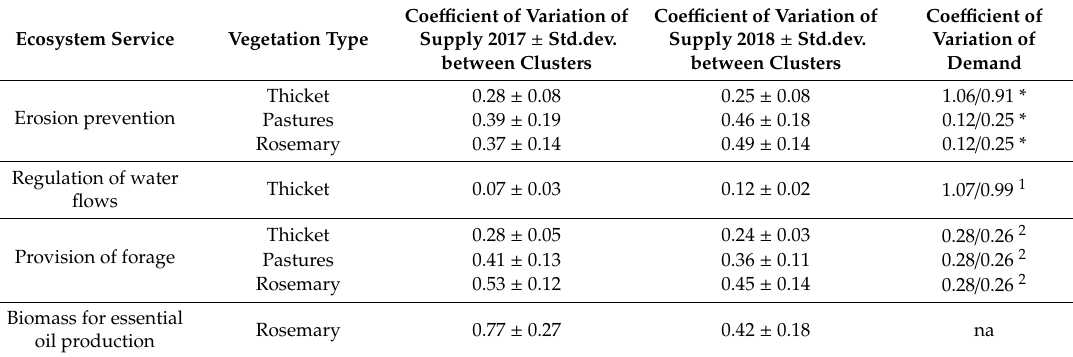
Table 4. Average coe ffi cient of variation of supply and demand between clusters in thicket, pastures, and rosemary fields during 2017 and 2018. Standard deviation